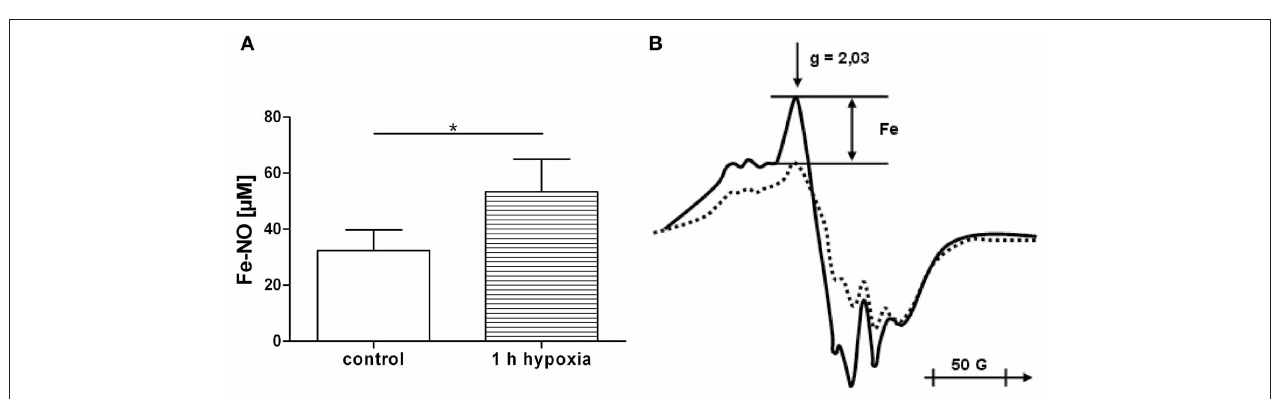
FIGURE 4 | (A,B) Accumulation of free iron in liver sections under hypoxia. The sections were treated with nitrite solution and frozen for EPR analysis either immediately after preparation (control) or after incubation for 1h at 37 ◦ C under nitrogen (1h hypoxia). The difference in free iron concentration between control and 1h hypoxia was approx.